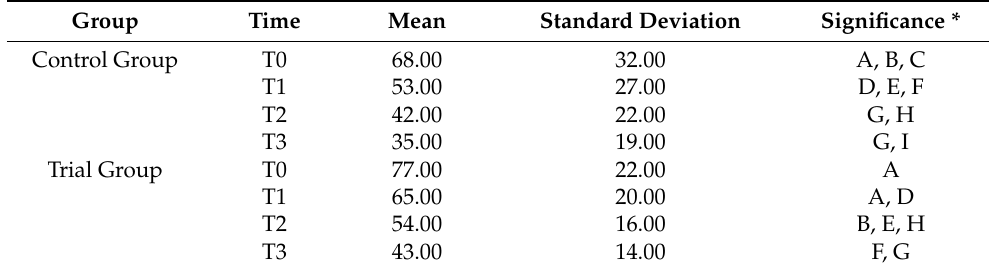
Table 5. Descriptive statistics of PI%